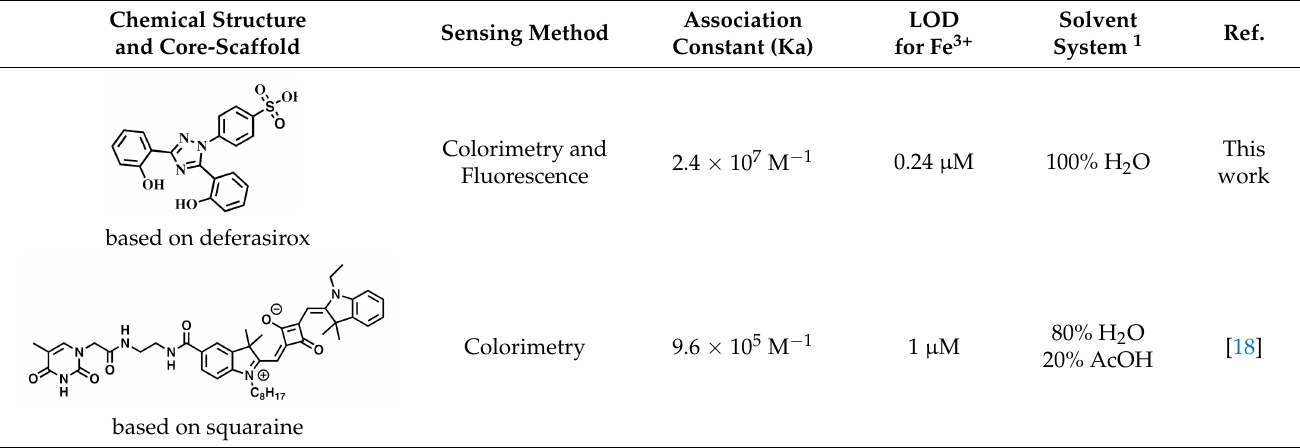
Table 1. Comparison of 2 with other reported Fe 3+